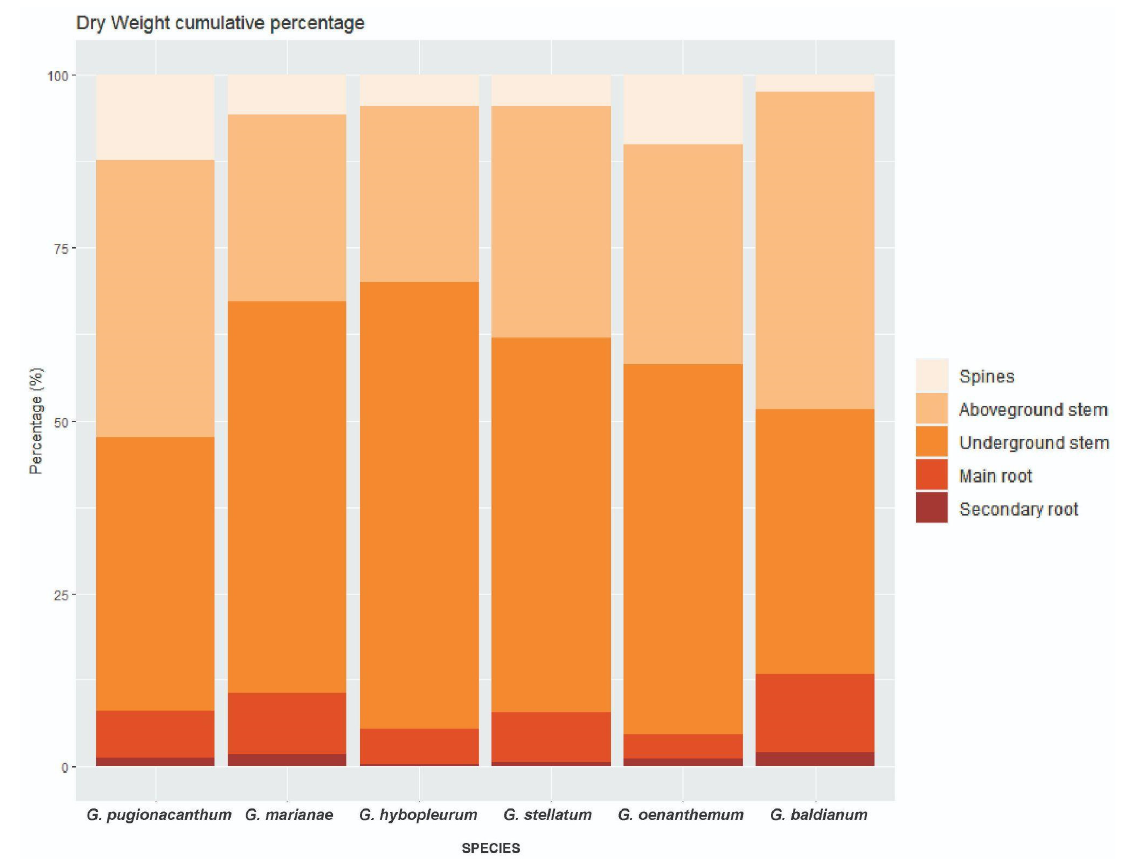
Figure 3. Biomass partitioning and allocation expressed as percentage of dry weight. Percentages correspond to each part of the plant. Species are ordered according to the precipitation gradient, from the arid ( G. pugionacanthum and G. marianae ) to the humid conditions ( G. oenanthemum and G. baldianum ).